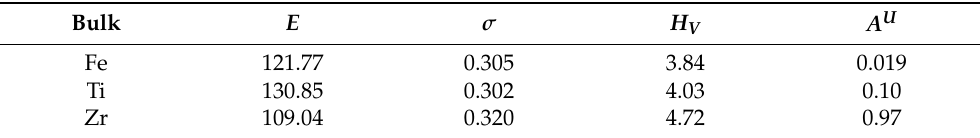
Table 2. Calculated values of Young’s modulus € , Poisson’s ratio ( σ ), hardness, and general anisotropy index ( A U ) for Fe, Ti, and Zr